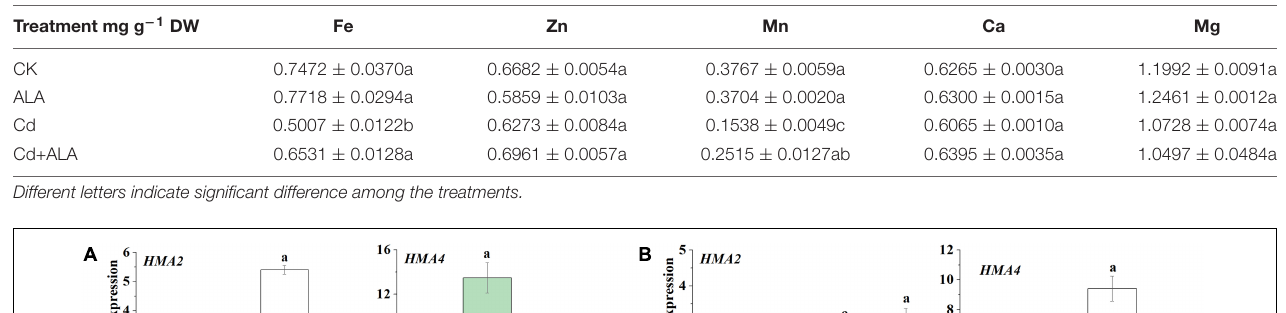
TABLE 3 | Effects of ALA on the concentrations of Fe 2 + , Zn 2 + , Mn 2 + , Ca 2 + , and Mg 2 + in roots under Cd stress.